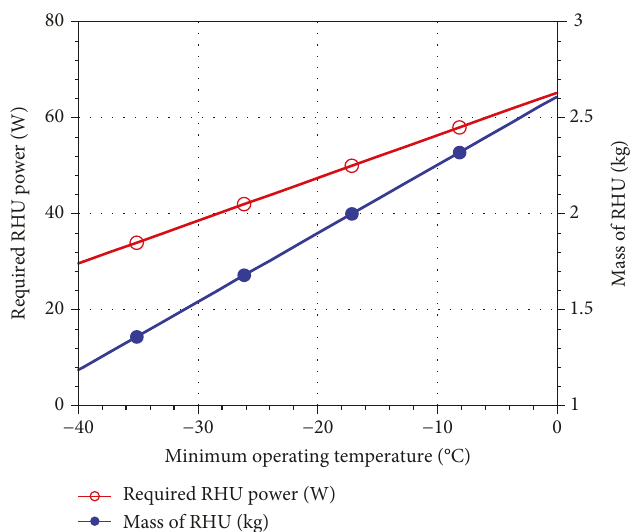
Figure 9: Temperatures of the lunar lander and mass of RHU according to the required power of RHU.